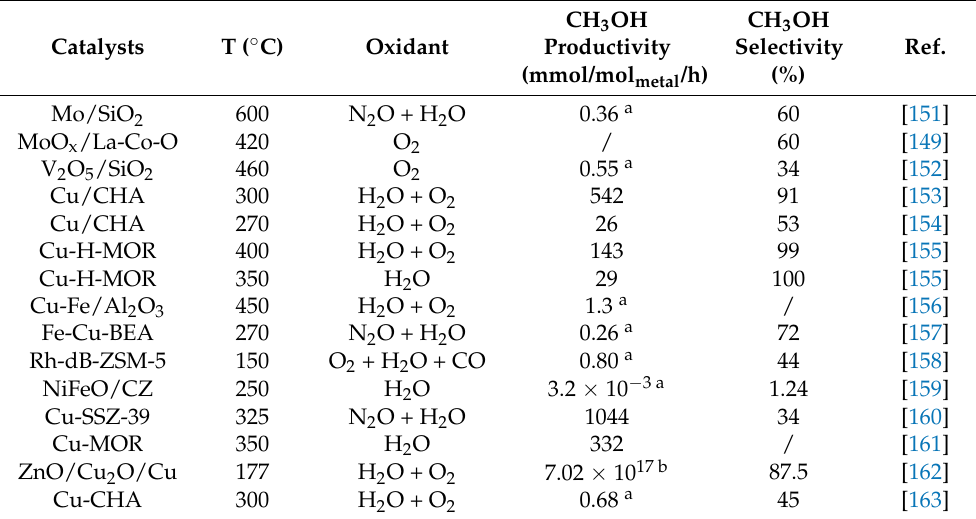
Table 2. Summary of catalysts and their catalytic activity for continuous gas-phase partial oxidation of methane into methanol.